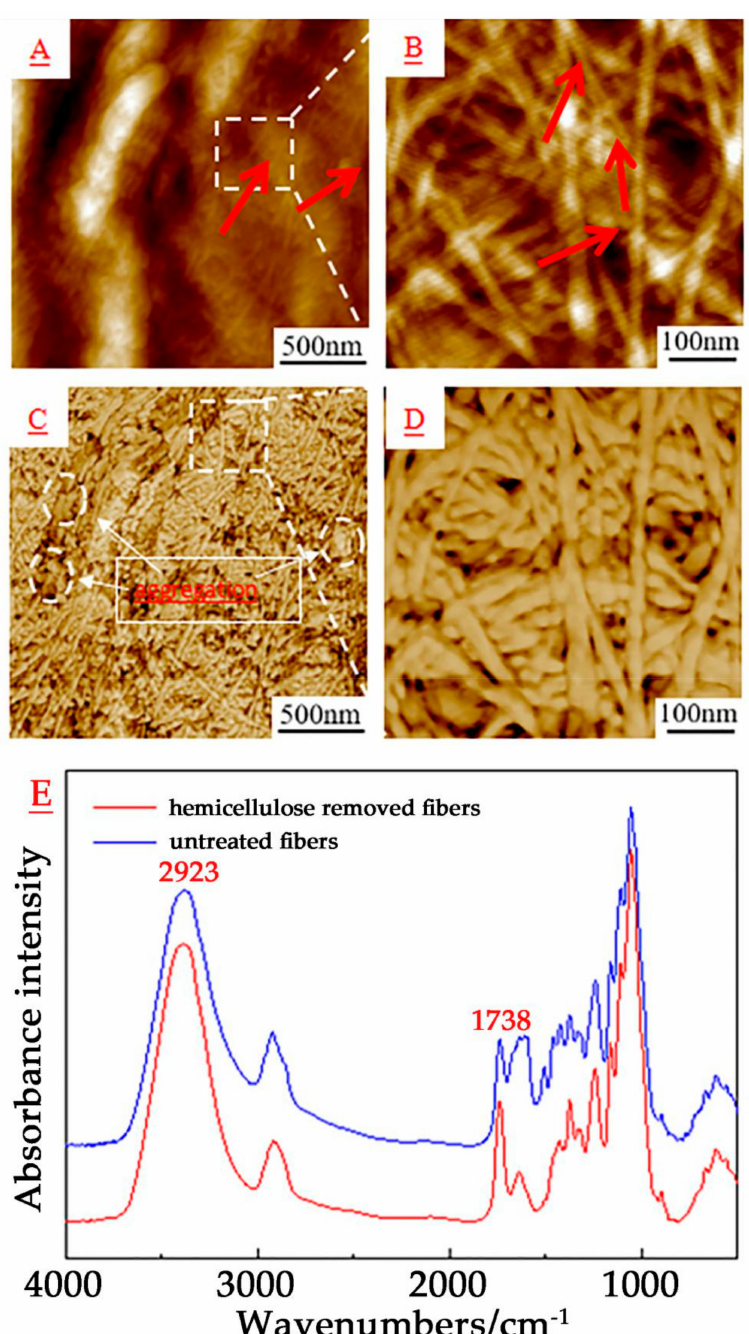
Figure 6. AFM images of the longitudinal surface of microfibrils arrangement of poplar catkin fibers treated with 2 wt.% potassium hydroxide (KOH) solution: ( A , B ) height images; ( C , D ) phase images; ( E ) FT-IR spectroscopy of untreated fibers and hemicellulose-removed